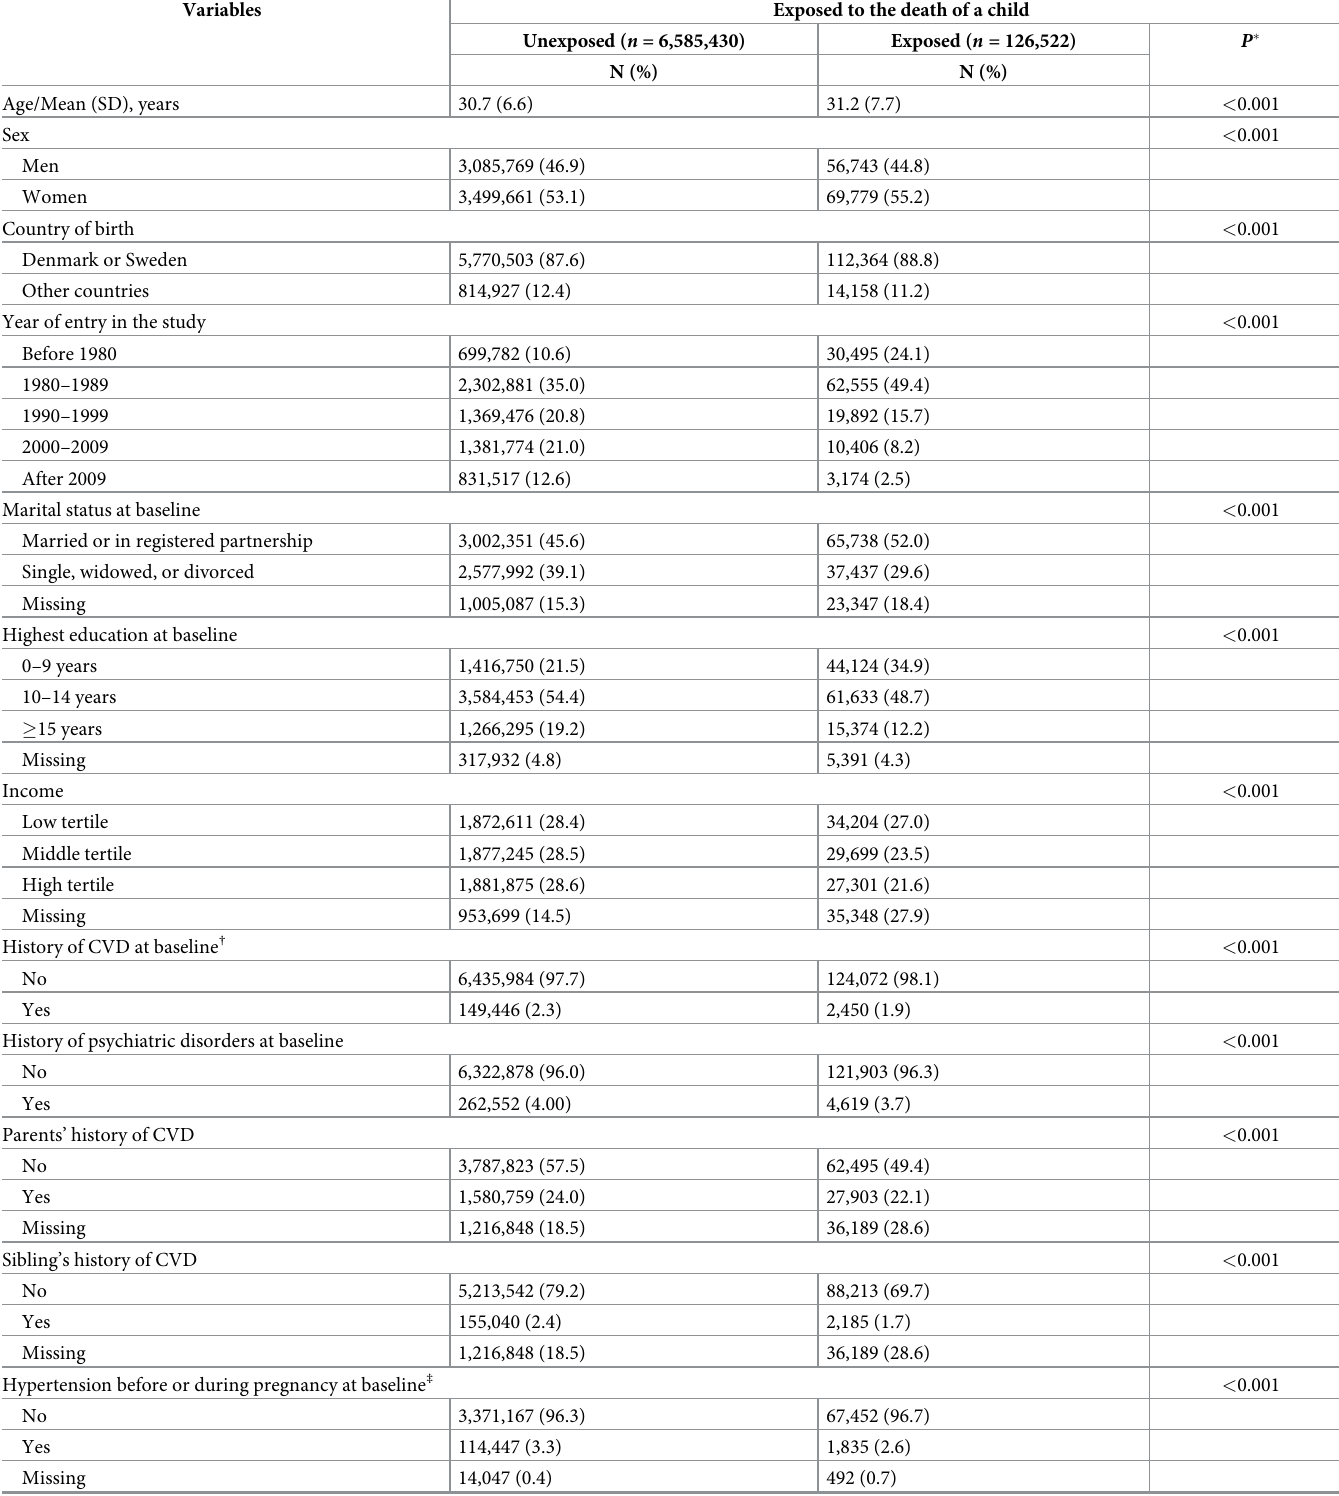
Table 1. Characteristics of the study population according to the death of a